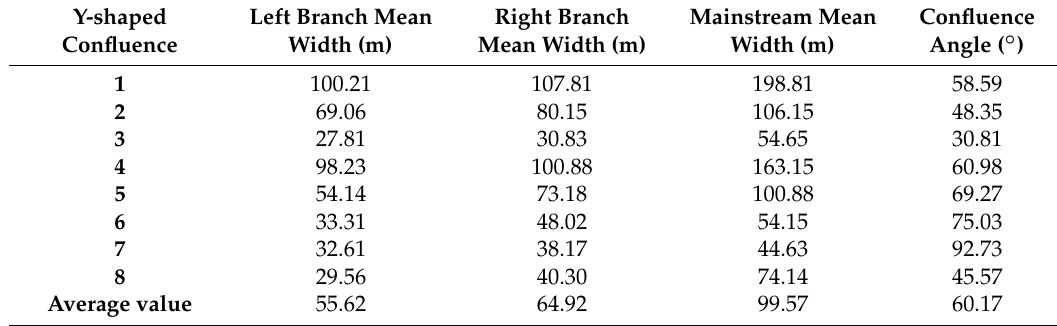
Table 1. Width and confluence angle of the river at the Y-shaped confluence channels.